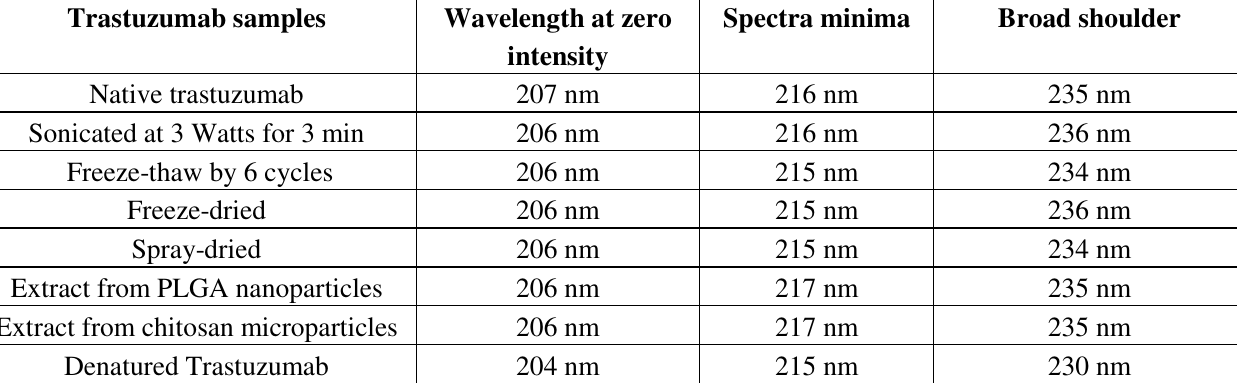
Table 2. Circular dichroism (CD) analysis of trastuzumab subjected to various mechanical stresses. Trastuzumab